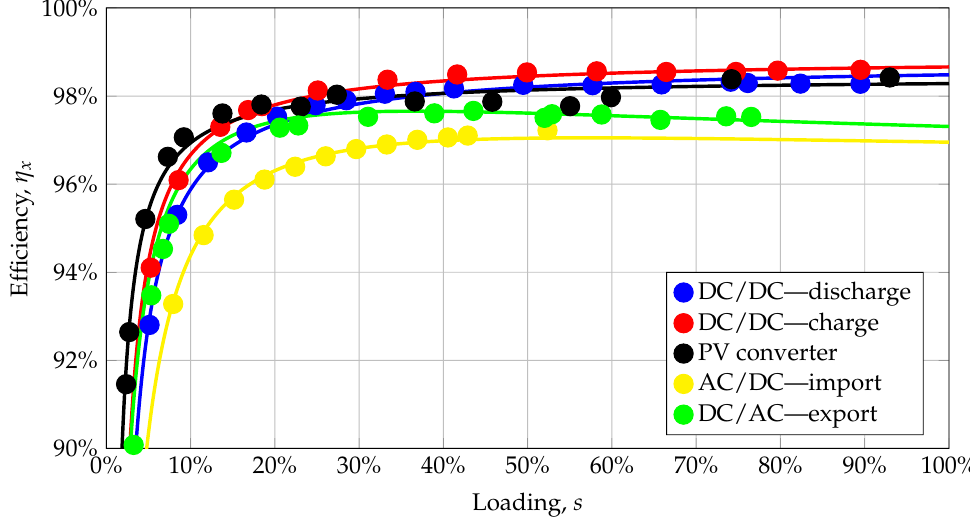
Figure 5. Resulting converter efficiency values and curve fit derived from measurements.